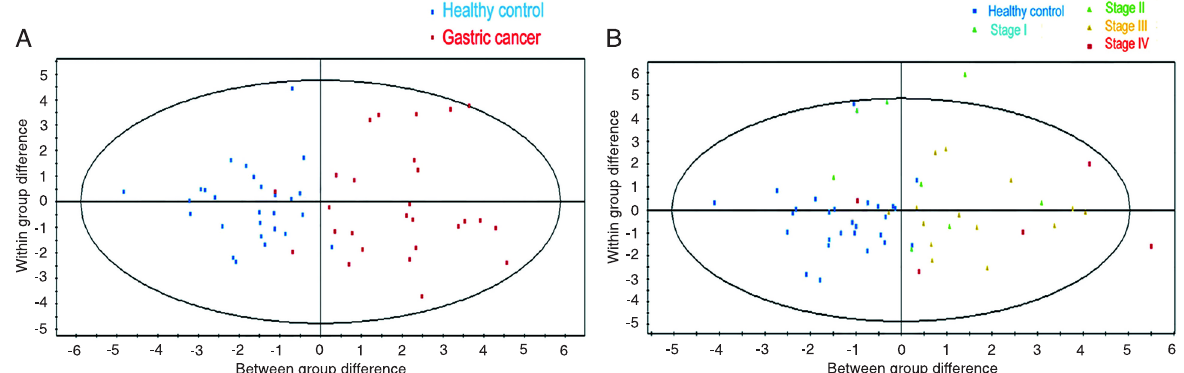
Figure 2. Establishment of orthogonal partial least squares discriminant analysis (OPLS-DA) models. A shows the score plot of OPLS- DA modeling for serum metabolomic data. It can be seen that healthy controls tended to cluster to the left, while the gastric cancer patients generally clustered to the right. The OPLS-DA model demonstrated satisfactory modeling and achieved a fairly distinct separa- tion between the two groups. B illustrates the score plot of normal control and different TNM stages and the model could not separate gastric cancer patients in different TNM stages although separation trends could be observed between the gastric cancer group and non-gastric cancer